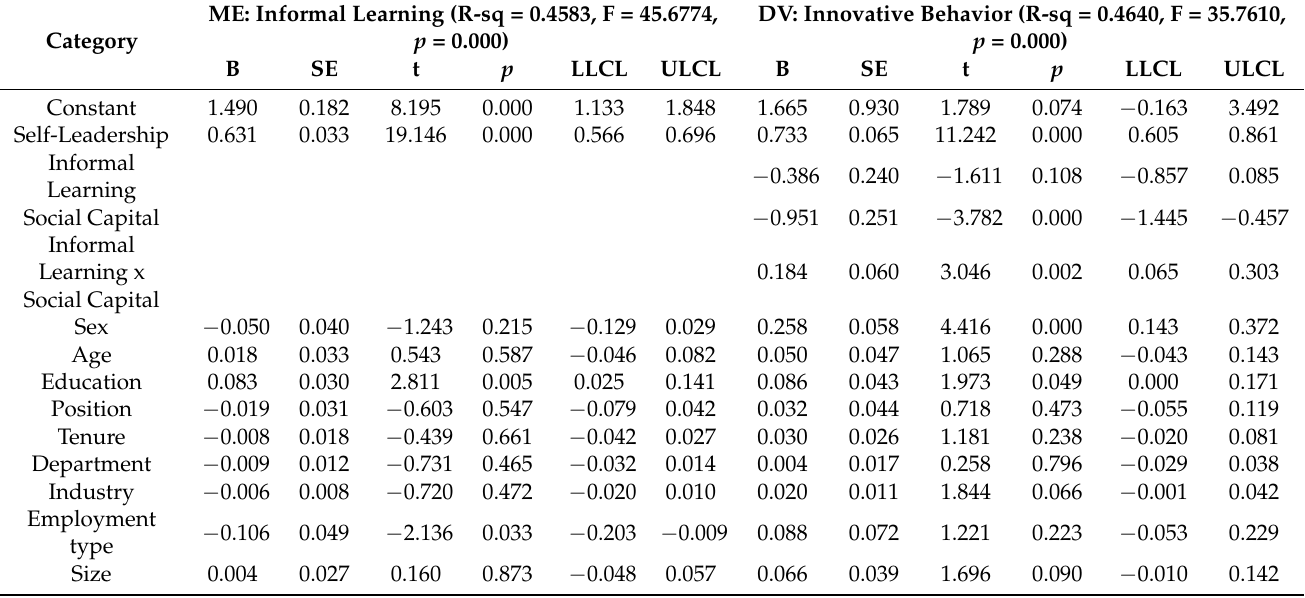
Table 6. Moderated mediating effect of social